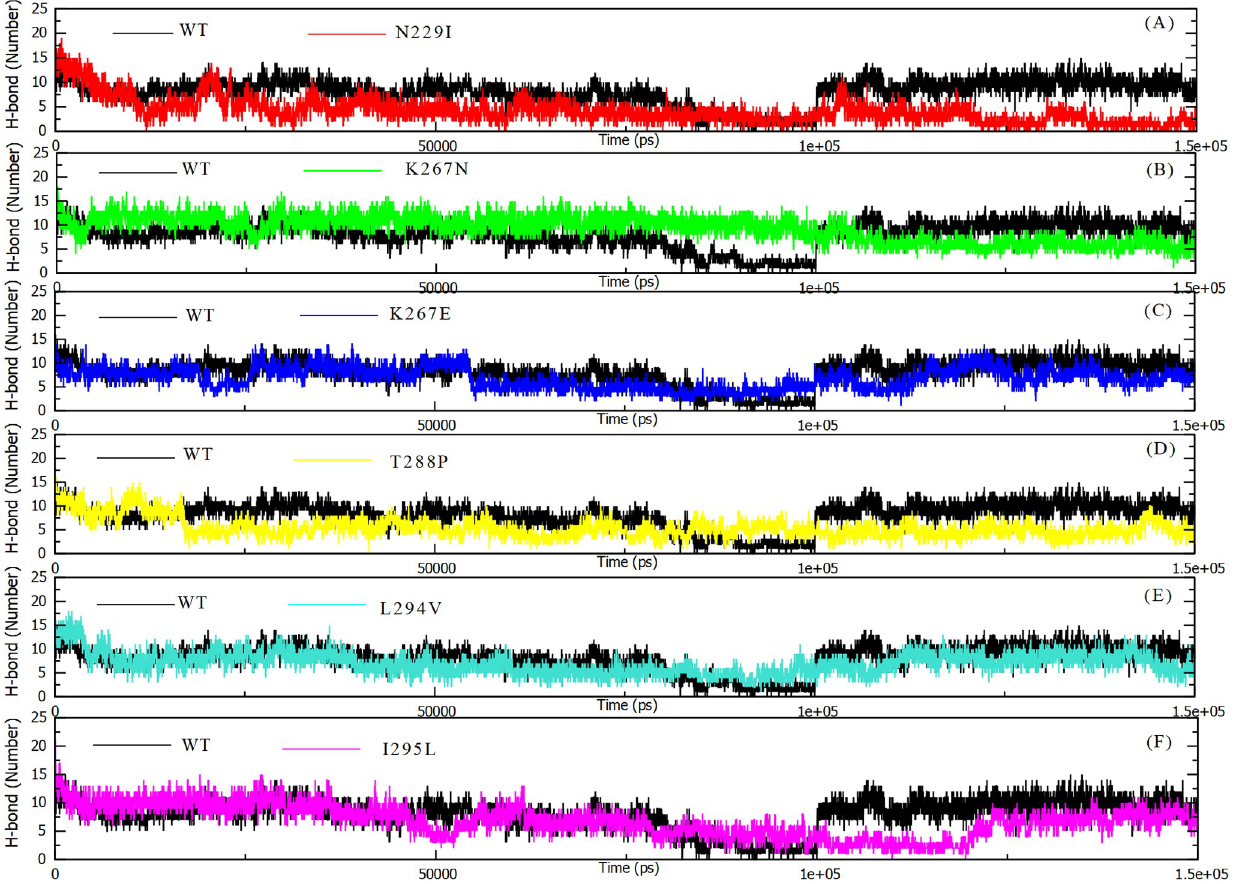
Fig 7. Number of hydrogen bonds at the interface level of interacting residues of MERS-CoV S1 RBD protein and human DPP4 wild and mutant types during 150 ns of the molecular dynamics simulation period. (a) H-bond 4L72-WT vs 4L72-N229I. (b) H-bond 4L72-WT vs 4L72-K267N. (c) H- bond 4L72-WT vs 4L72-K267E. (d) H-bond 4L72-WT vs 4L72-T288P. (e) H-bond 4L72-WT vs 4L72-L294V. (f) H-bond 4L72-WT vs 4L72-I295L.